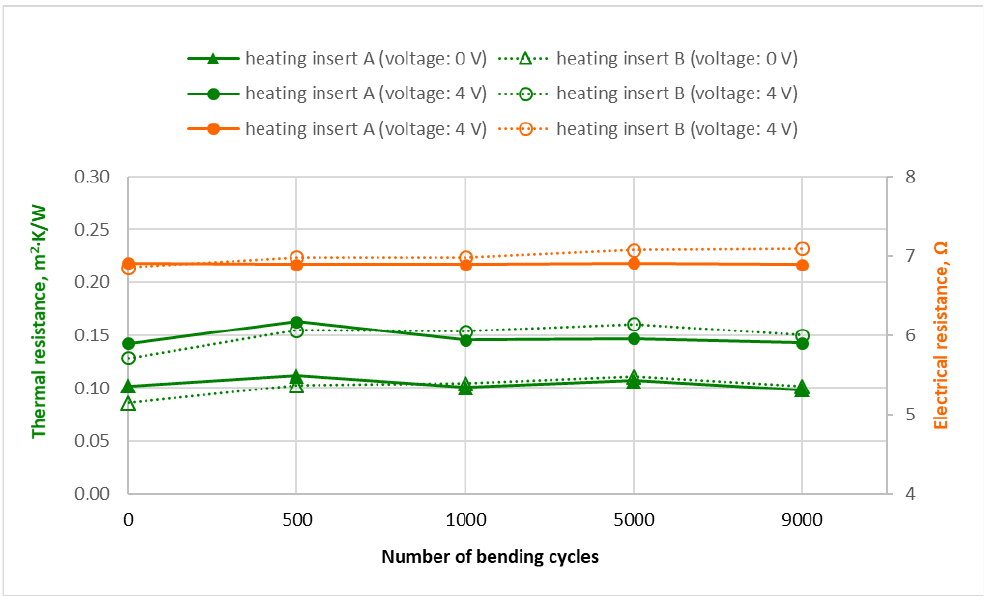
Figure 9. Thermal resistance test results for systems of materials incorporating heating inserts A and B depending on the number of bending and twisting cycles.